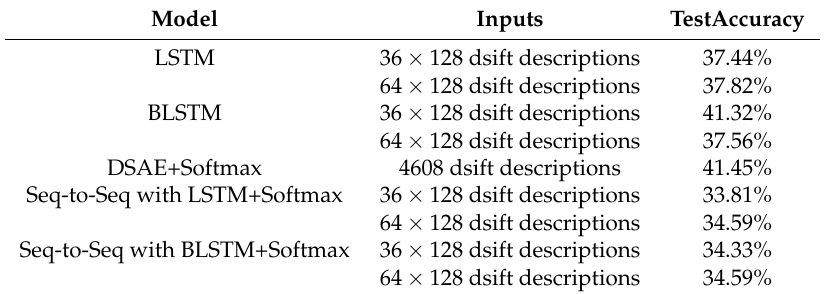
Table 6. The performance of sequence models and autoencoder on the RAF Compound test